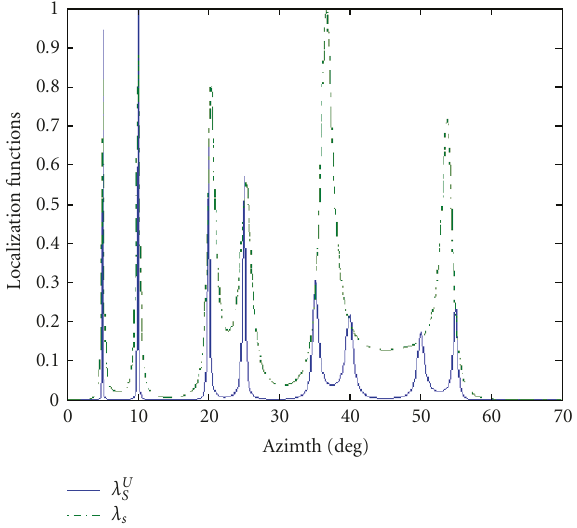
Figure 8: EG algorithm as a function of the threshold values λ U λ s with m = 10 and SNR = − 5dB.